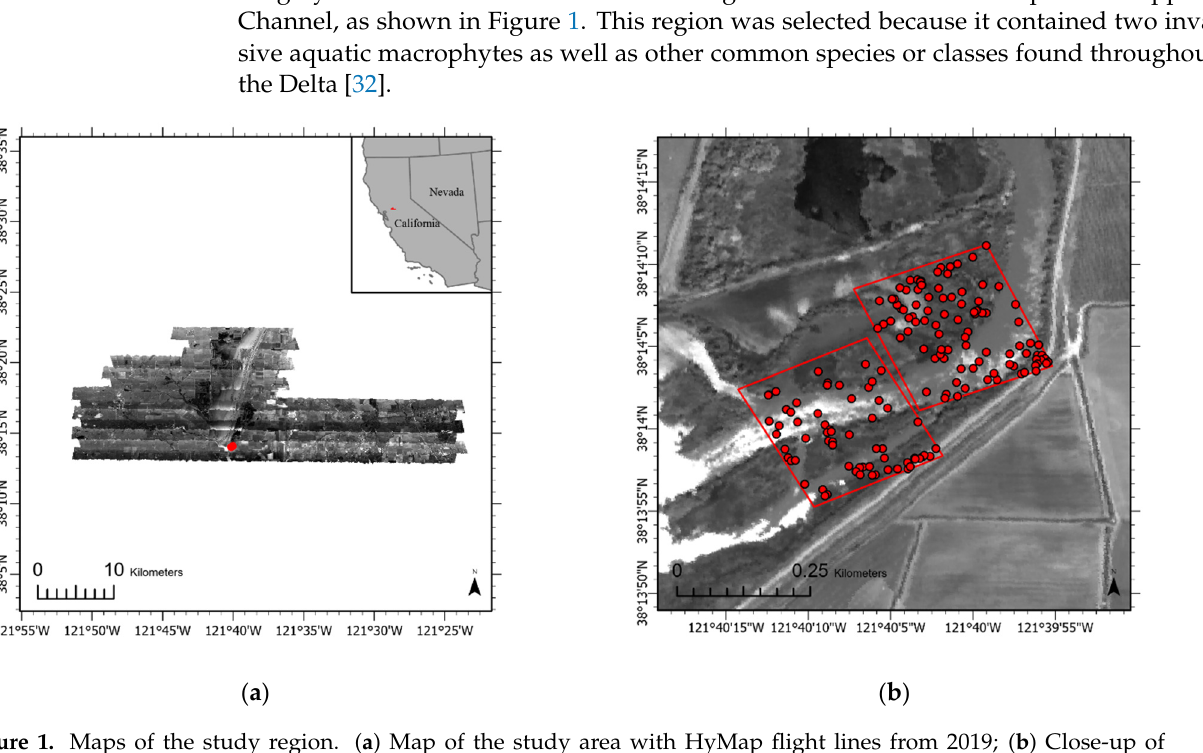
Figure 1. Maps of the study region. ( a ) Map of the study area with HyMap flight lines from 2019; ( b ) Close-up of Nano-Hyperspec acquisition area and ground reference